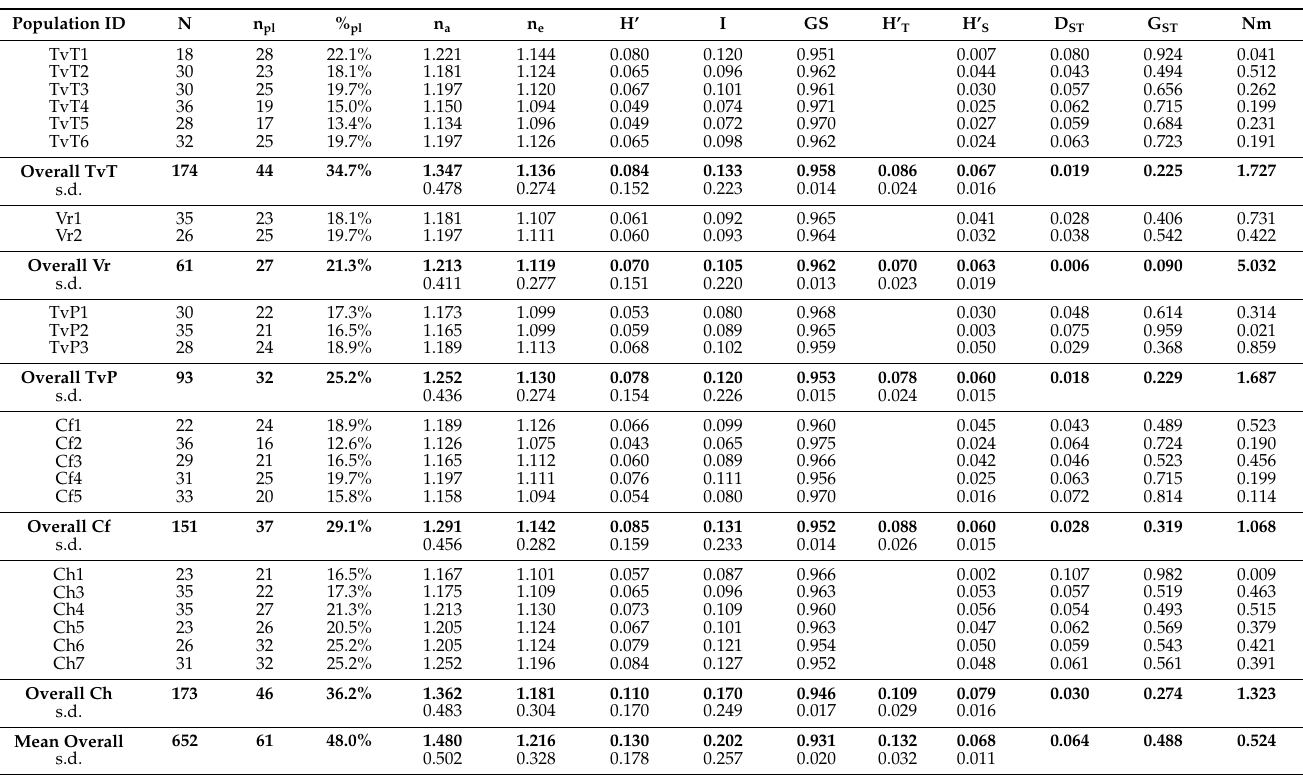
Table 2. Descriptive statistics over all marker loci including the number of individuals (N), number (n pl ) and percentage (% pl ) of polymorphic loci, mean number of observed (n a ) and effective (n e ) alleles per locus, Nei’s genetic diversity (H’) Shannon’s information index (I), Dice’s genetic similarity (GS) coefficient, total genetic diversity per biotype and overall (H’ T ), expected heterozygosity (H’ S ) within biotypes and overall, genetic differentiation (D ST ) and proportional genetic diversity (G ST ), and gene flow estimates